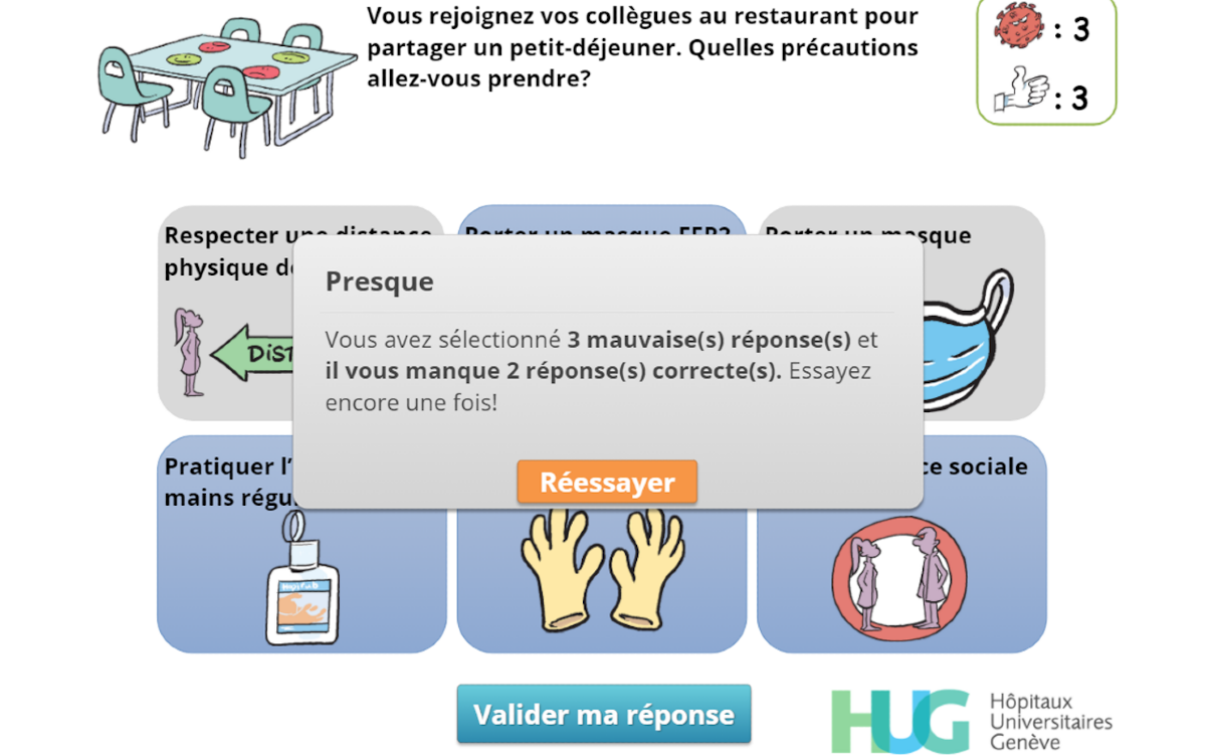
Figure 4. Feedback. The player has submitted an initial answer and is informed that they have selected 3 wrong answers (“3 mauvaises réponses”) and that 2 correct answers are missing (“il vous manque 2 réponses correctes”). They can retry (“Réessayer”) once.